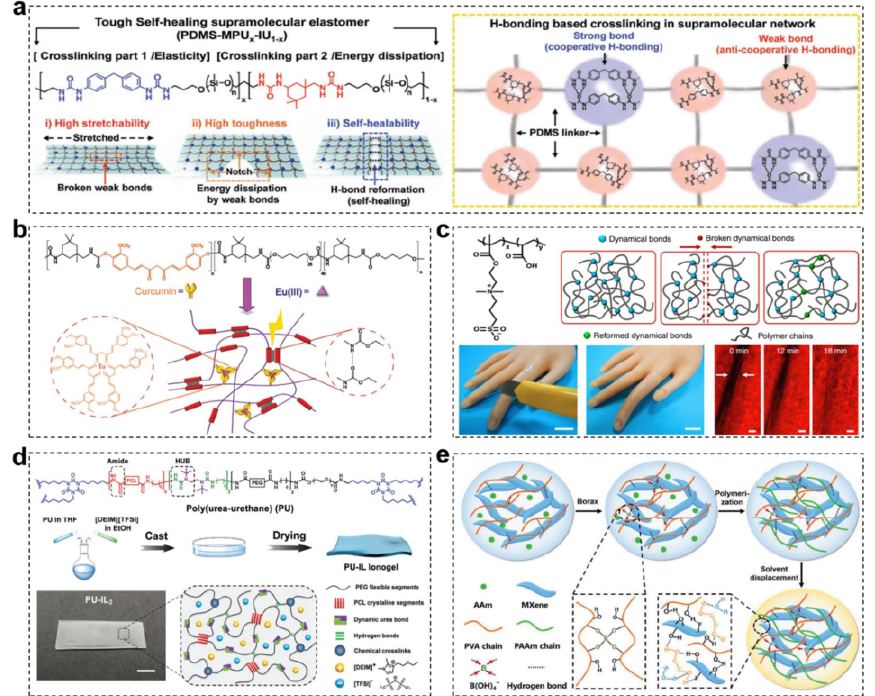
Figure 5. ( a ) Chemical structure of the supramolecular elastomer and possible hydrogen bonding combinations for strong bond and weak bond, respectively. Schematics of a stretched polymer film, a notched film, and a healed film. Reproduced with permission [149]. Copyright 2018, Wiley-VCH. ( b ) Molecular structure of curcumin (Cur)-embedded polymer. A schematic depiction of Eu (III) coordinated P-Cur material, highlighting the Eu-curcumin coordination bonds and the hydrogen bond derived from the urethane groups. Reproduced with permission [153]. Copyright 2018, Wiley- VCH. ( c ) The chemical structure of the polyelectrolyte and the schematic illustration of the dynamic process. Photos of a biomimetic skin whose hydrogel layer is cut into half and the healed biomimetic skin. Direct observation of the reconfiguration and autonomous self-healing of the dynamic networks by time-resolved fluorescence microscopic images (scale bar: 20 µ m). Reprinted with permission from ref. [81], Copyright 2018 Springer Nature. ( d ) Chemical structure of the PU network and schematic of the fabrication process of PU-IL ionogels. Digital image of PU-IL2 ionogel and its corresponding schematic structure. Reproduced with permission [157]. Copyright 2020, Wiley- VCH. ( e ) Schematic illustration of the fabrication of a conductive, anti-freezing, and self-healing organohydrogel-based strain sensor with dual dynamic crosslinking networks. Reproduced with permission [159]. Copyright 2019,